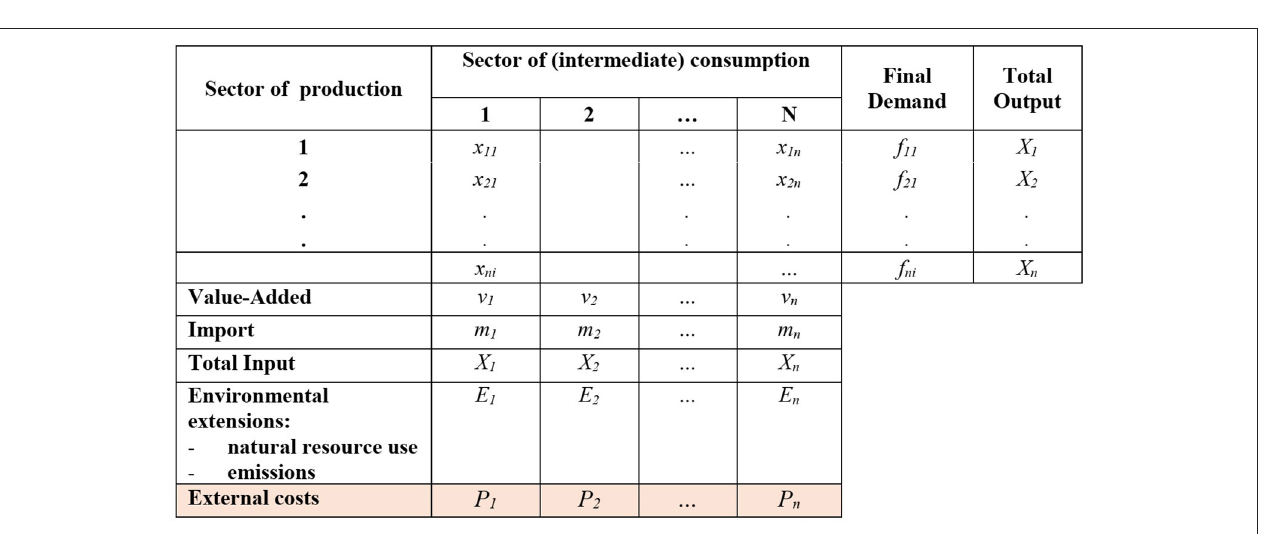
FIGURE 2 | Structure of the Indonesian environmentally extended input-output